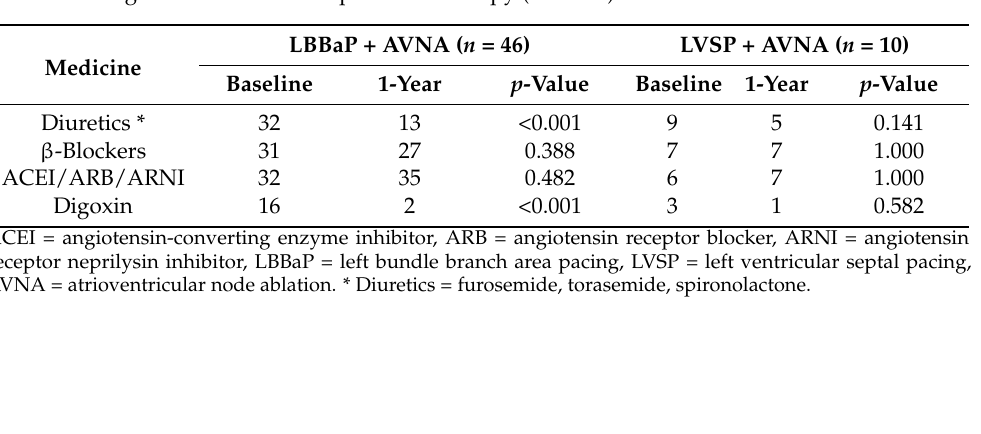
Table 6. Changes in cardiovascular pharmacotherapy